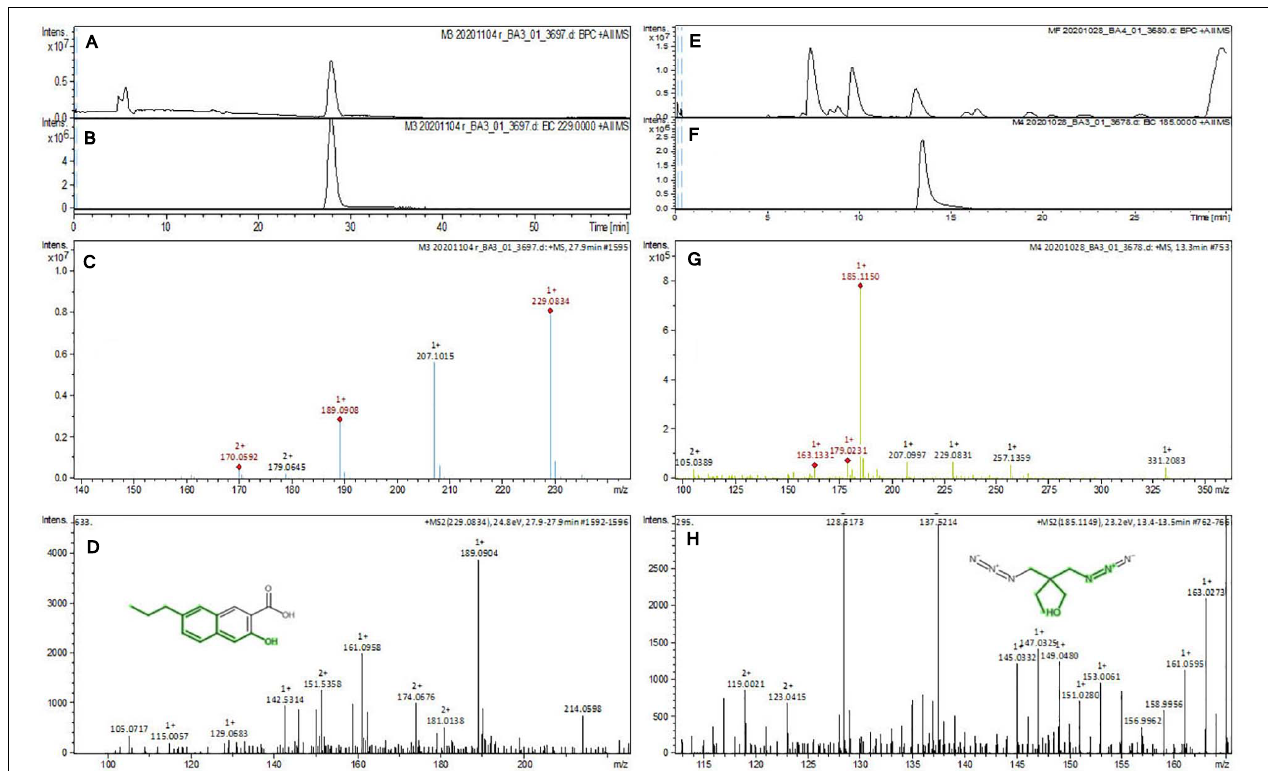
FIGURE 12 | Liquid chromatogram profile from culture filtrate extract of B. petrensis (A) and liquid chromatogram profile of purified M3 fraction (B) and M4 fraction (C) . The LC peak at Rt 27.9 and 13.4 displaying the purified bioactive fractions M3 and M4 corresponding to fungal culture filtrate extract Rt 33.31 and 13.7, respectively (A,B,E,F) . The mass spectrum displaying the feature m/z 229.08, 185.11 [M+H] + of compounds 3-hydroxy-7-propyl-naphthalene-2-carboxylic acid and 2,2-bis(azidomethyl)butan-1-ol obtained a similar characteristic feature of molecular mass in ME with a positive ion mode (C,D,G,H)